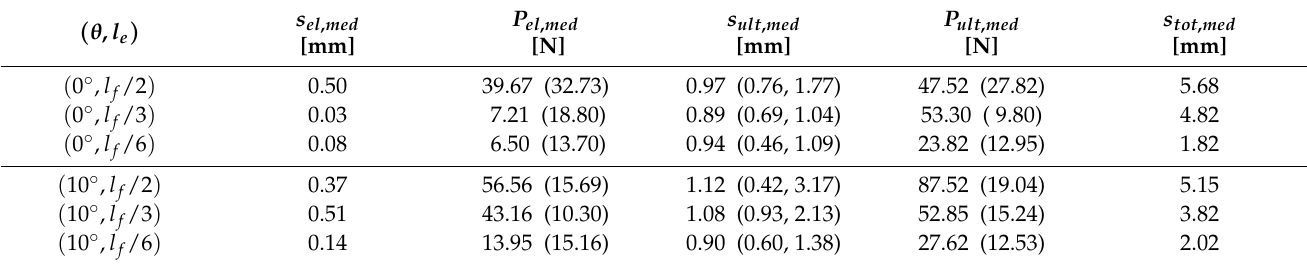
Table A1. Median values s el , med ( θ , l e ) , P el , med ( θ , l e ) (standard deviations given in brackets), s ult , med ( θ , l e ) (minimum and maximum values given in brackets), P ult , med ( θ , l e ) (standard deviations given in brackets), s tot , med ( θ , l e ) . No values for sd P and sd P were determined for the combination el , med ult , med ( θ , l e ) = ( 80 ◦ , l ) , as only one single-fibre pull-out curve could be f /6